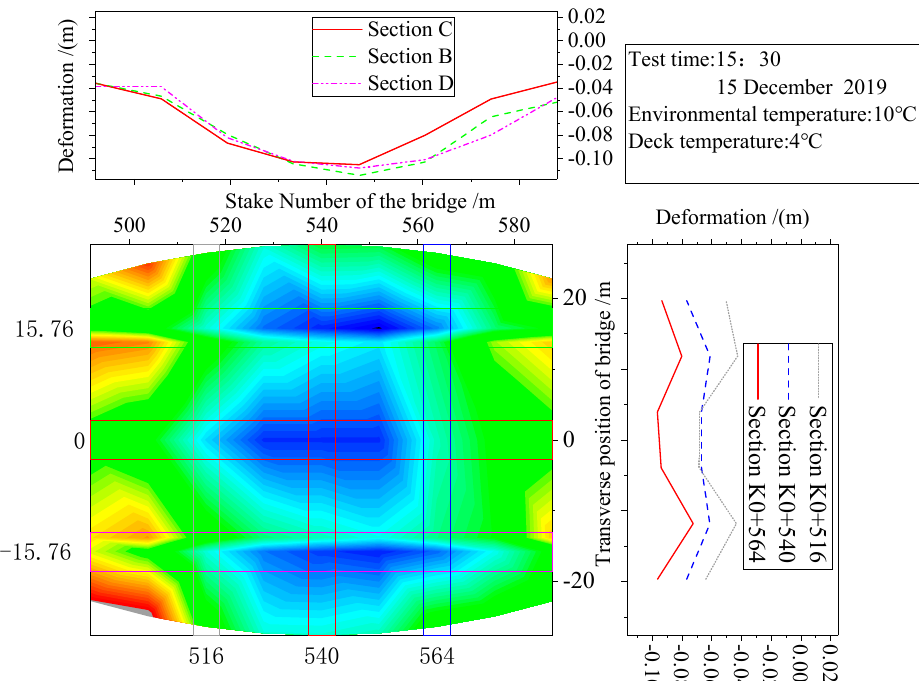
Figure 33. Deformation of the whole box girder before rehabilitation measures.